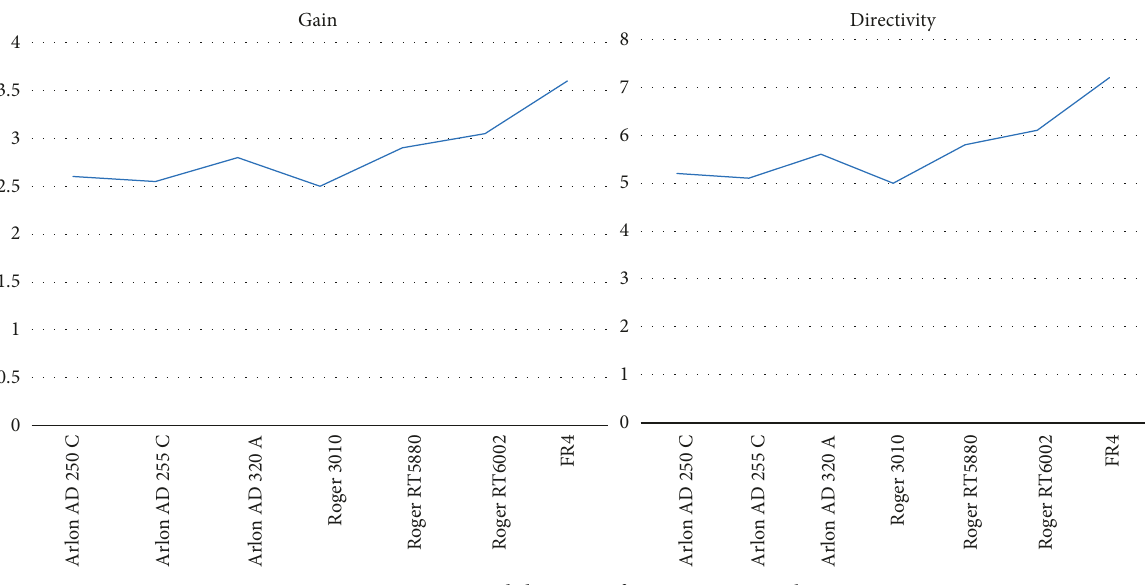
Figure 6: Gain and directivity for various materials.